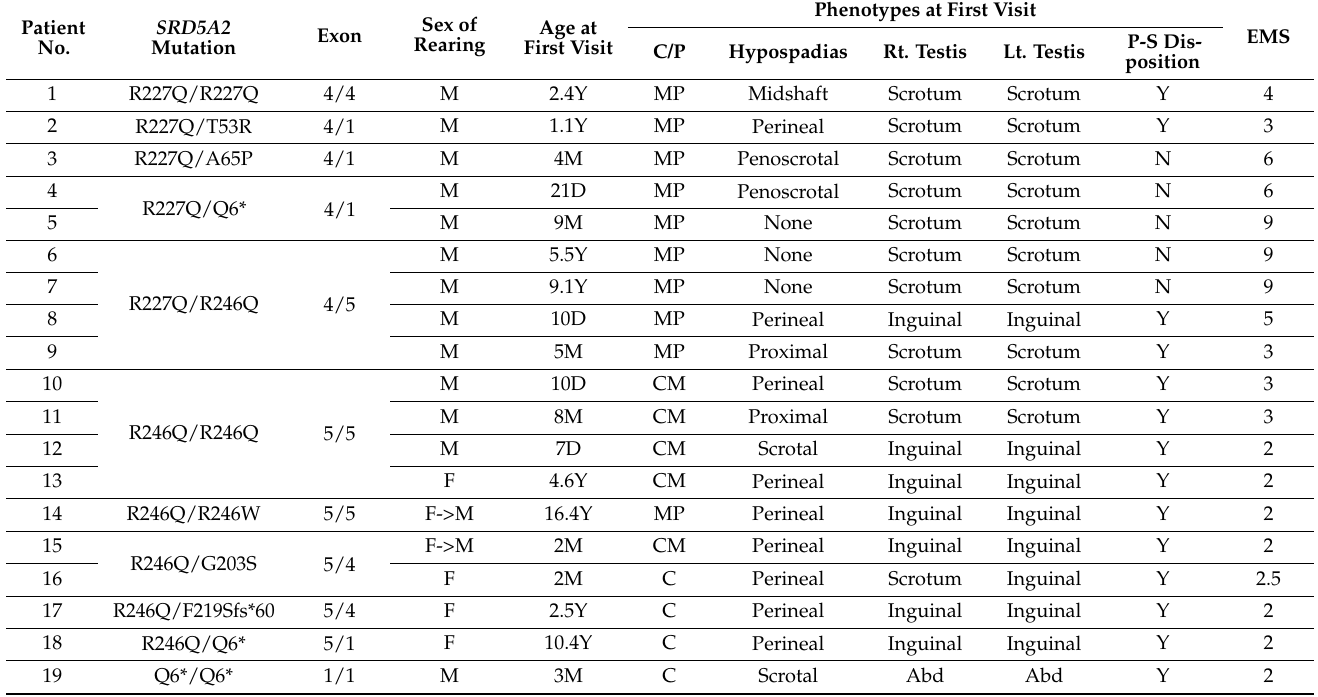
Table 1. Molecular and clinical data of patients with 5 α -reductase